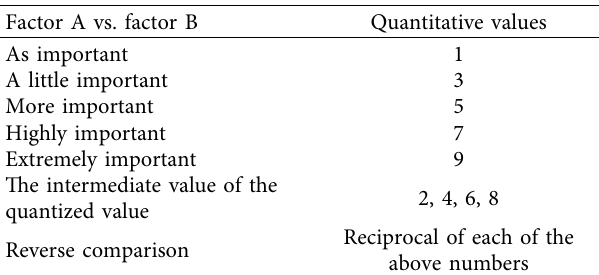
Table 3: RI values corresponding to the